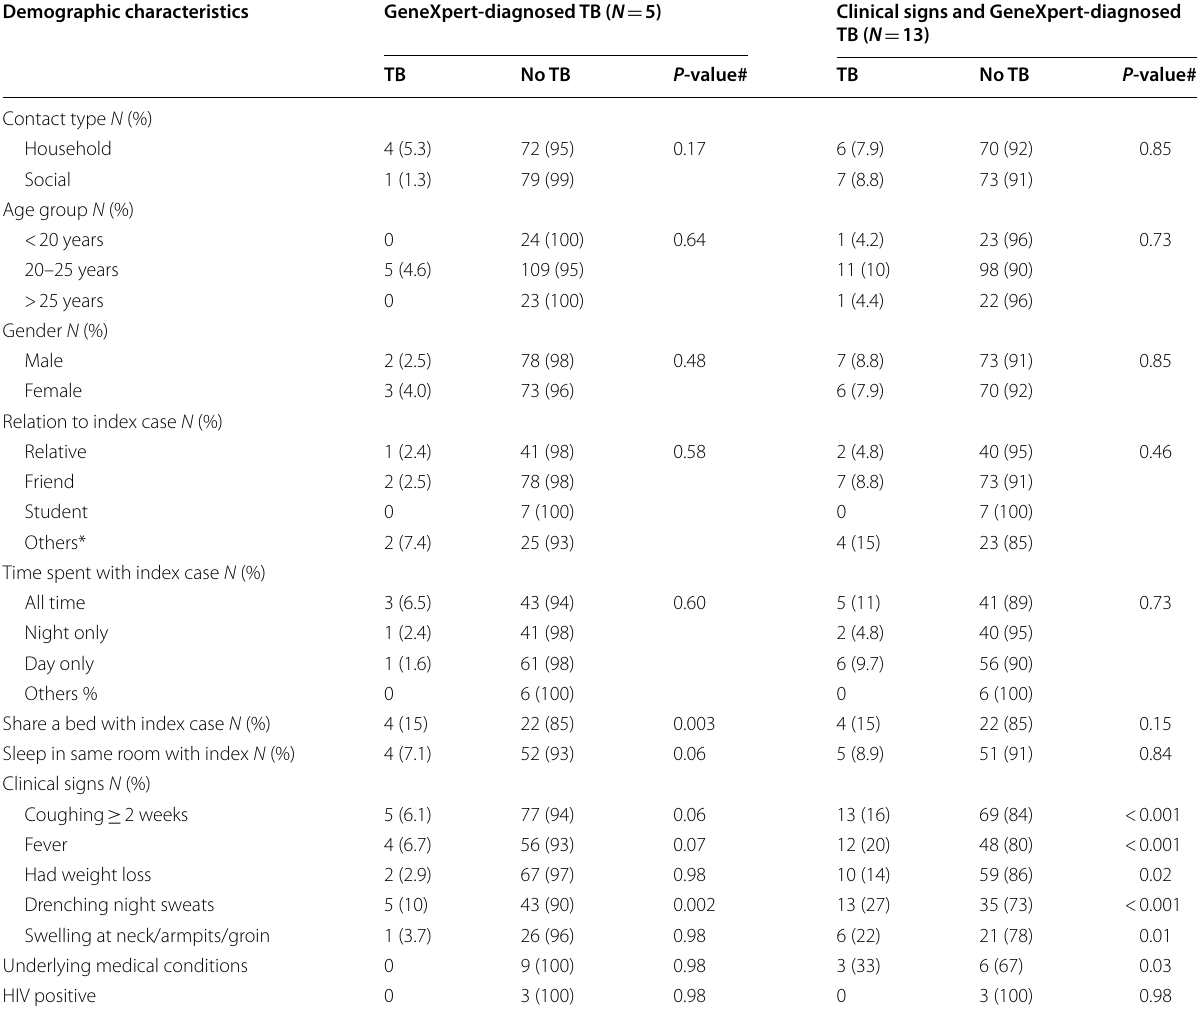
Table 3 Comparison of contacts with and without GeneXpert-diagnosed TB Demographic